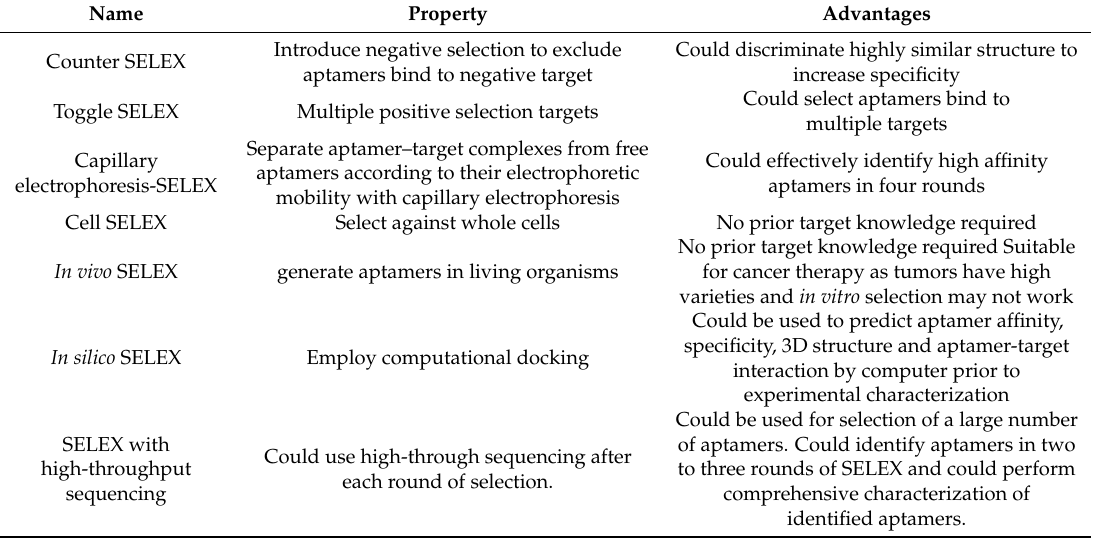
Table 1. List of modified Systematic Evolution of Ligands by EXponential Enrichment (SELEX) methods which are commonly